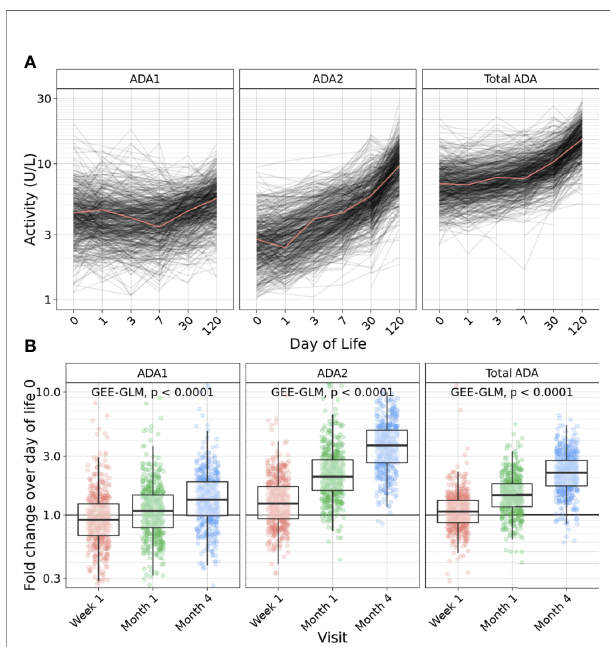
FIGURE 3 | Plasma ADA concentrations increased across the fi rst four months of life. (A) Concentration of ADA1 (left), ADA2 (middle) and Total ADA (right) during the fi rst 128 days of life in the Gambian cohort showed an increase of ADA1, ADA2 and total ADA concentrations across the fi rst four months of life (n = 540 participants). (B) Log 10 fold-change of ADA1 (left), ADA2 (middle) and Total ADA (right) relative to day of life (DOL) 0 in the Gambian cohort demonstrated an increase of ADA1, ADA2 and total ADA concentrations during the fi rst four months of life (n = 491-511) (p<0.0001). Statistical analyses fi t a GEE-GLM to log 10 (activity) with Visit as a predictor variable, using Gaussian distribution, identity link function, and exchangeable covariance structure. Deviance analysis was conducted by comparing GEE to a null model, and p-values were found using the Wald statistic.